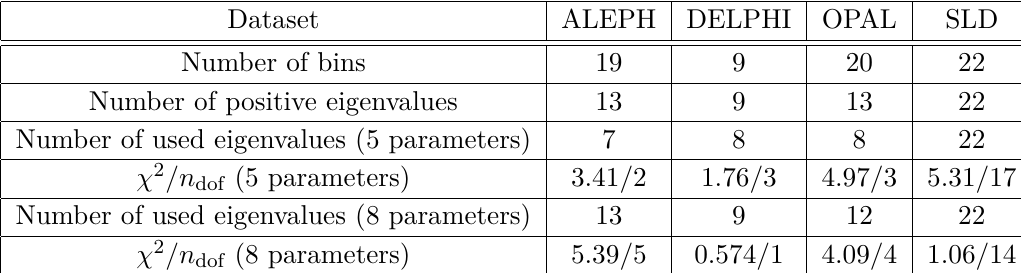
Table 1 . The number of bins, number of positive eigenvalues of the covariance matrix, number of used eigenvalues for both central fits and the χ 2 /n